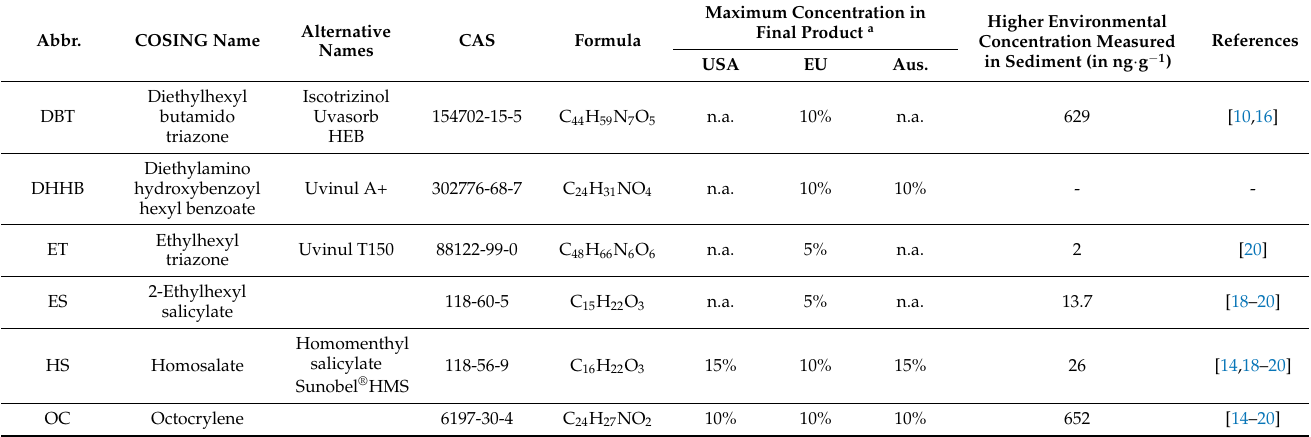
Table 1. UV filters tested and their environmental occurrence. a USA: United States of America; EU: European Union; Aus.: Australia; n.a.: not